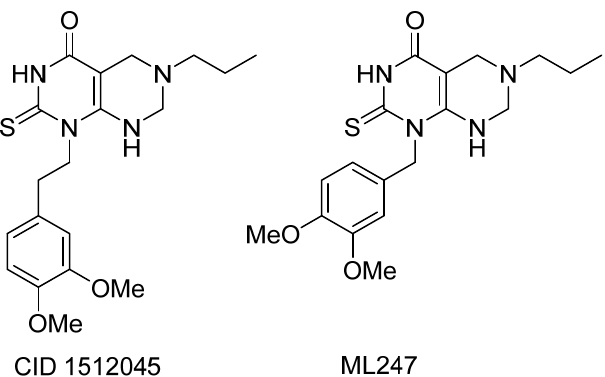
Figure 7. Structures of CID1512045 and ML247.